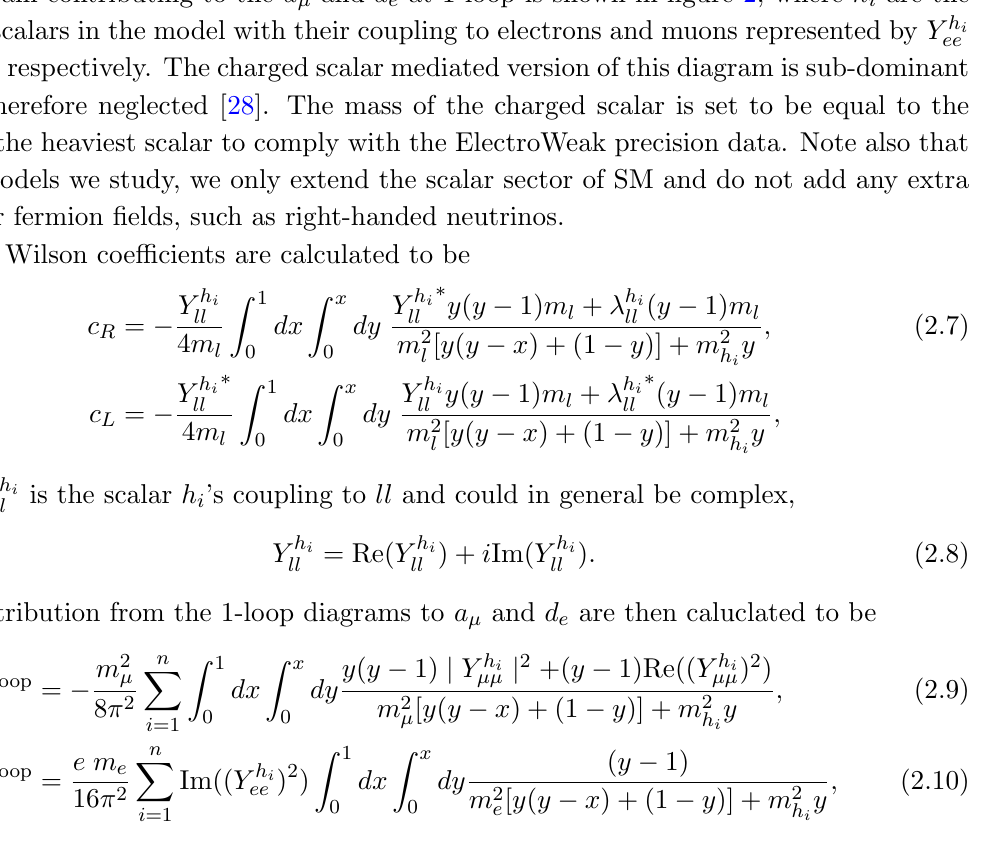
Figure 2 . The 1-loop diagram mediated by neutral scalars h i contributing to muon anomalous magnetic moment ( l = (cid:22) ) and to e EDM ( l = e